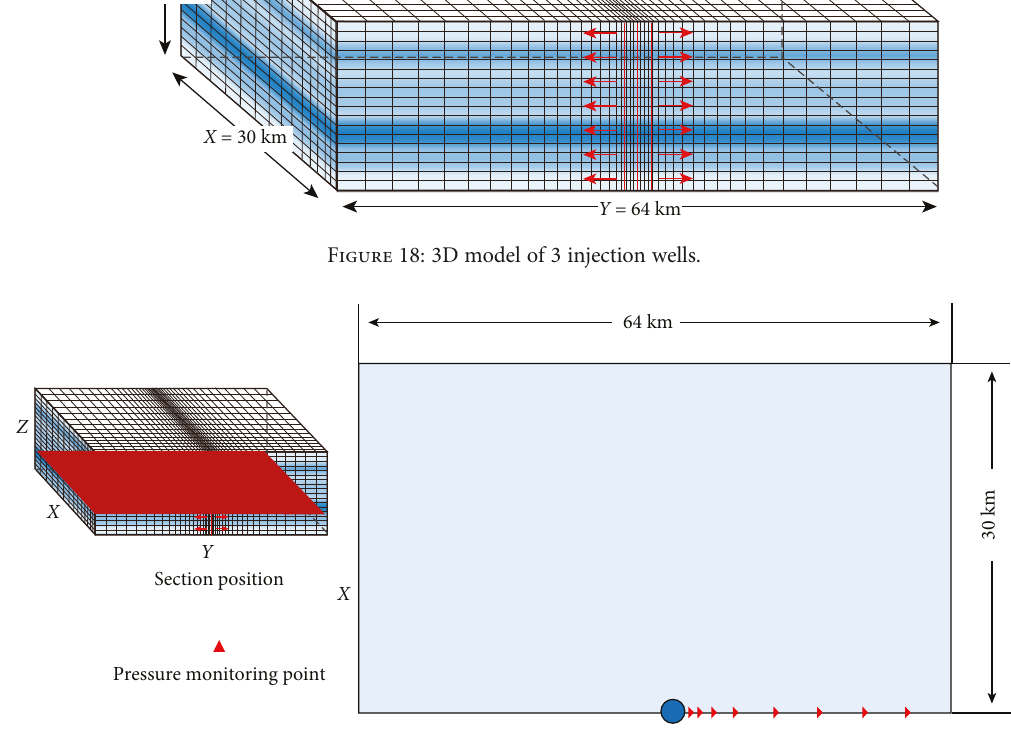
Figure 19: Locations of the pressure monitoring points in the 1-well